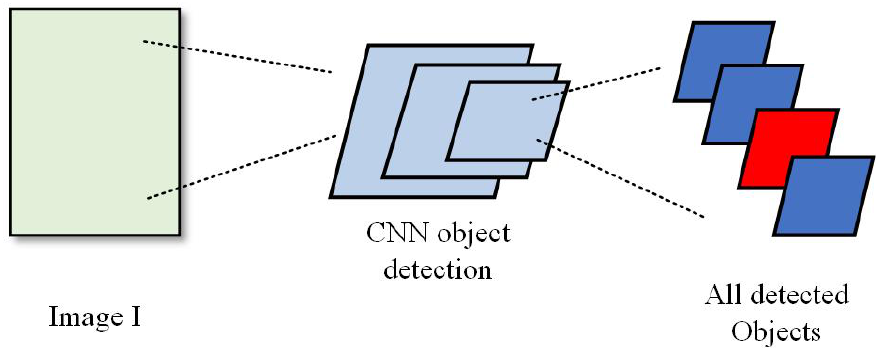
Figure 5. The diagram of object detection part in our image de-identification (DE-ID) framework.